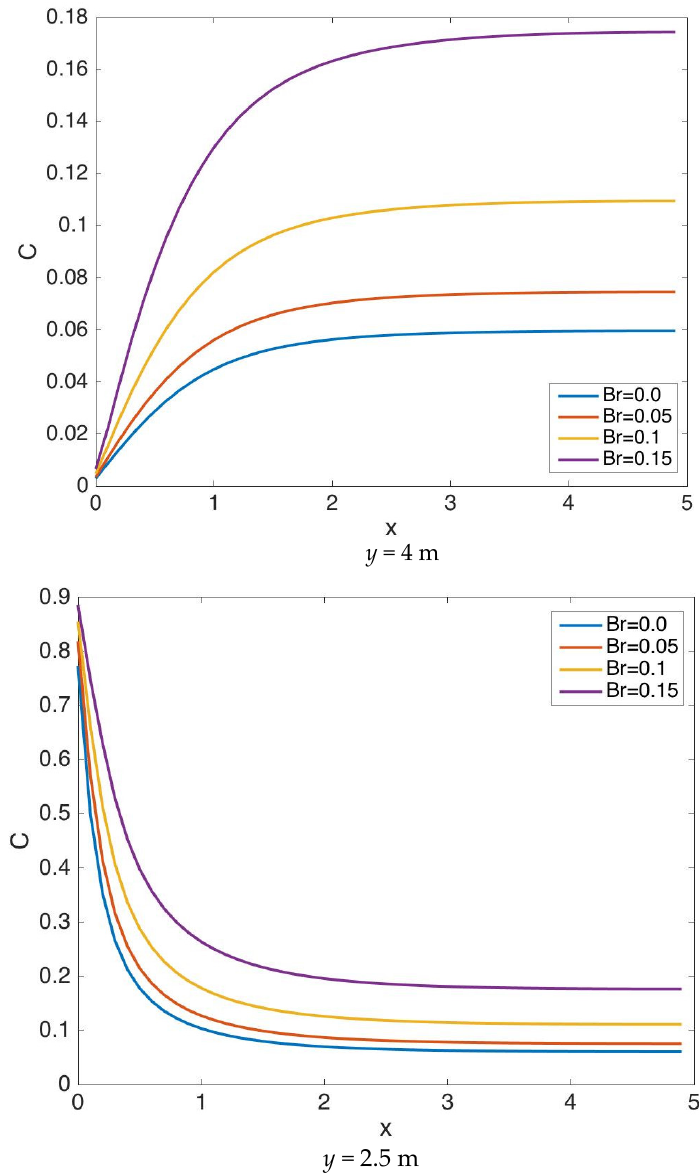
Figure 12. Concentration profiles against x -axis at y = 4 m, 2.5 m, for various values of Br of Case 2.